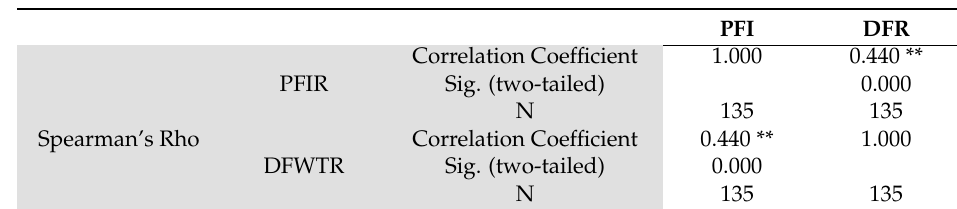
Table 3. Spearman’s rank-order correlation between perception of financial incentives and drivers for